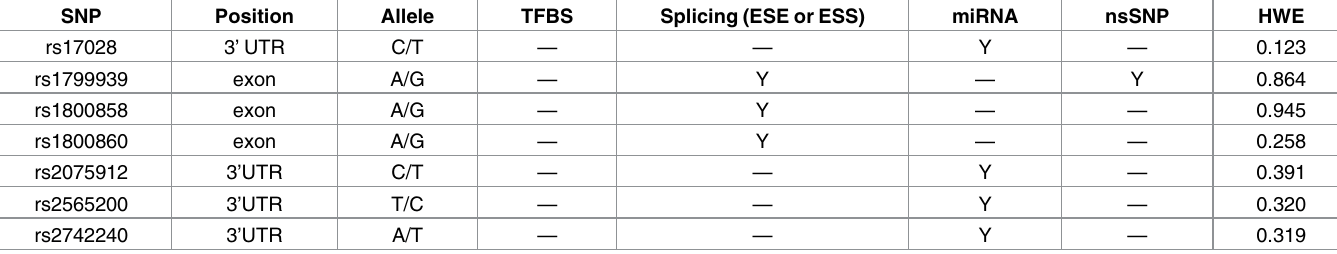
Table 1. Functional prediction of seven tagSNPs of the RET